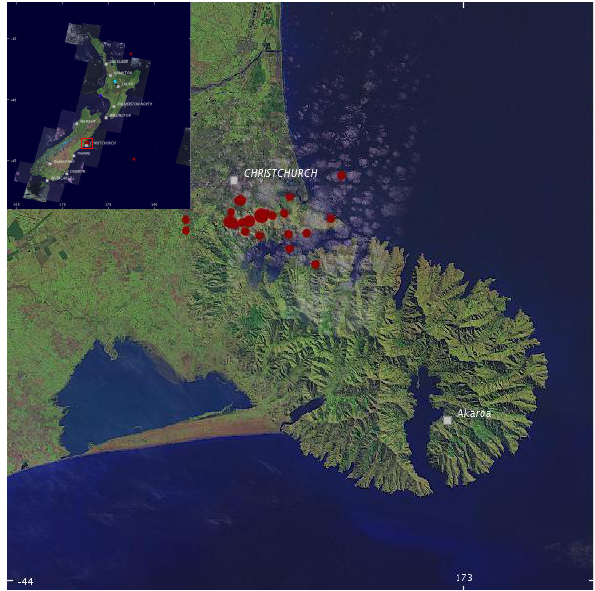
Fig. 2. The epicenter distribution map of M L ≥ 4.5 earthquakes of the aftershock sequence of the M L = 6.3 New Zealand earth- quake. Data are from the Earthquake Commission and GNS Sci- ence in New Zealand.